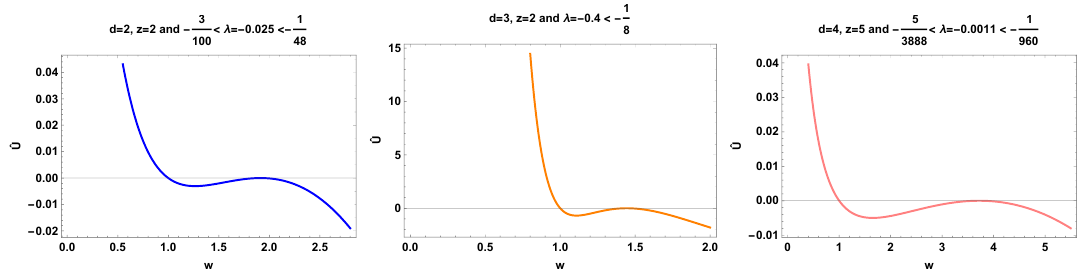
ˆ Figure 6 . The effective potential U ( w ) as a function of w for θ = 0 and different values of d , z and λ . For the values of λ given in table 2, there is a maximum w fA 2 outside the